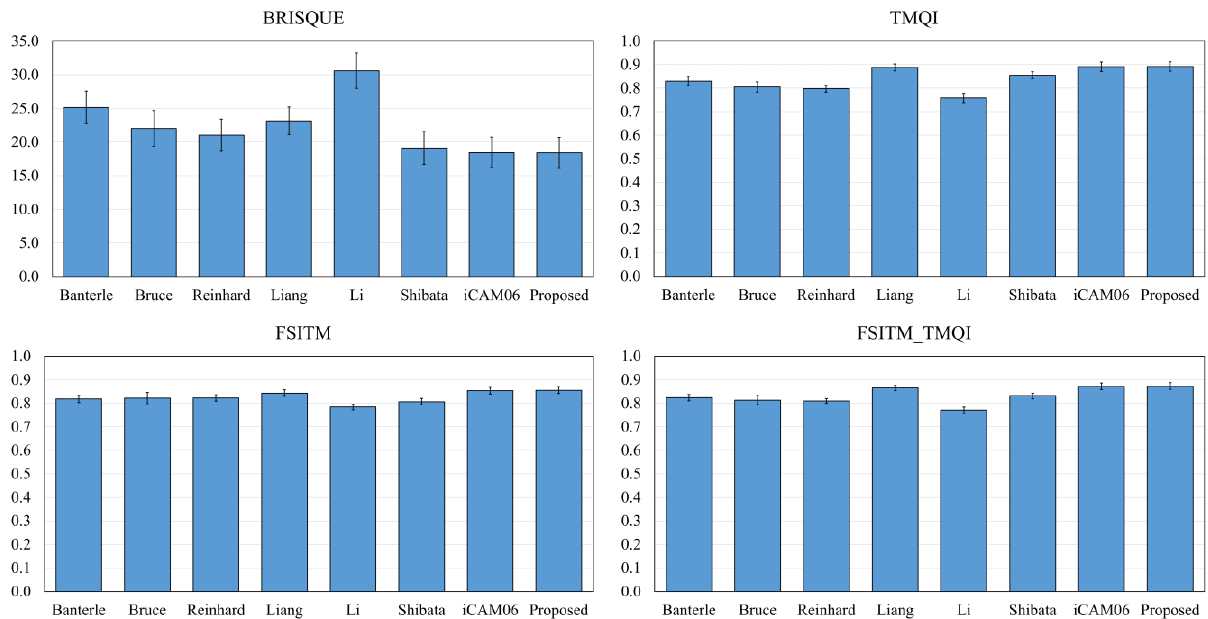
Figure 12. Image quality assessment scores for each method. Better image quality is represented by a lower BRISQUE score or higher TMQI, FSITM, and FSITM_TMQI scores.